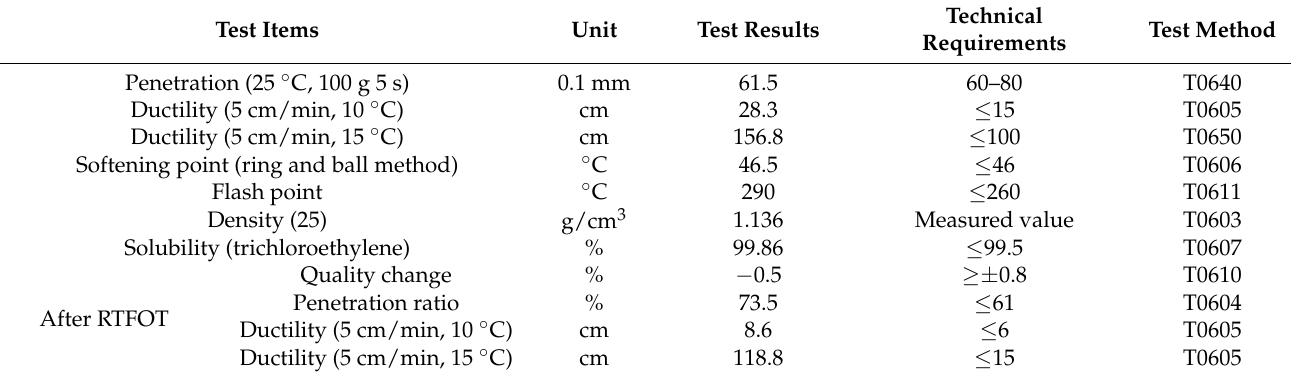
Table 1. Basic performance index of 70# asphalt.